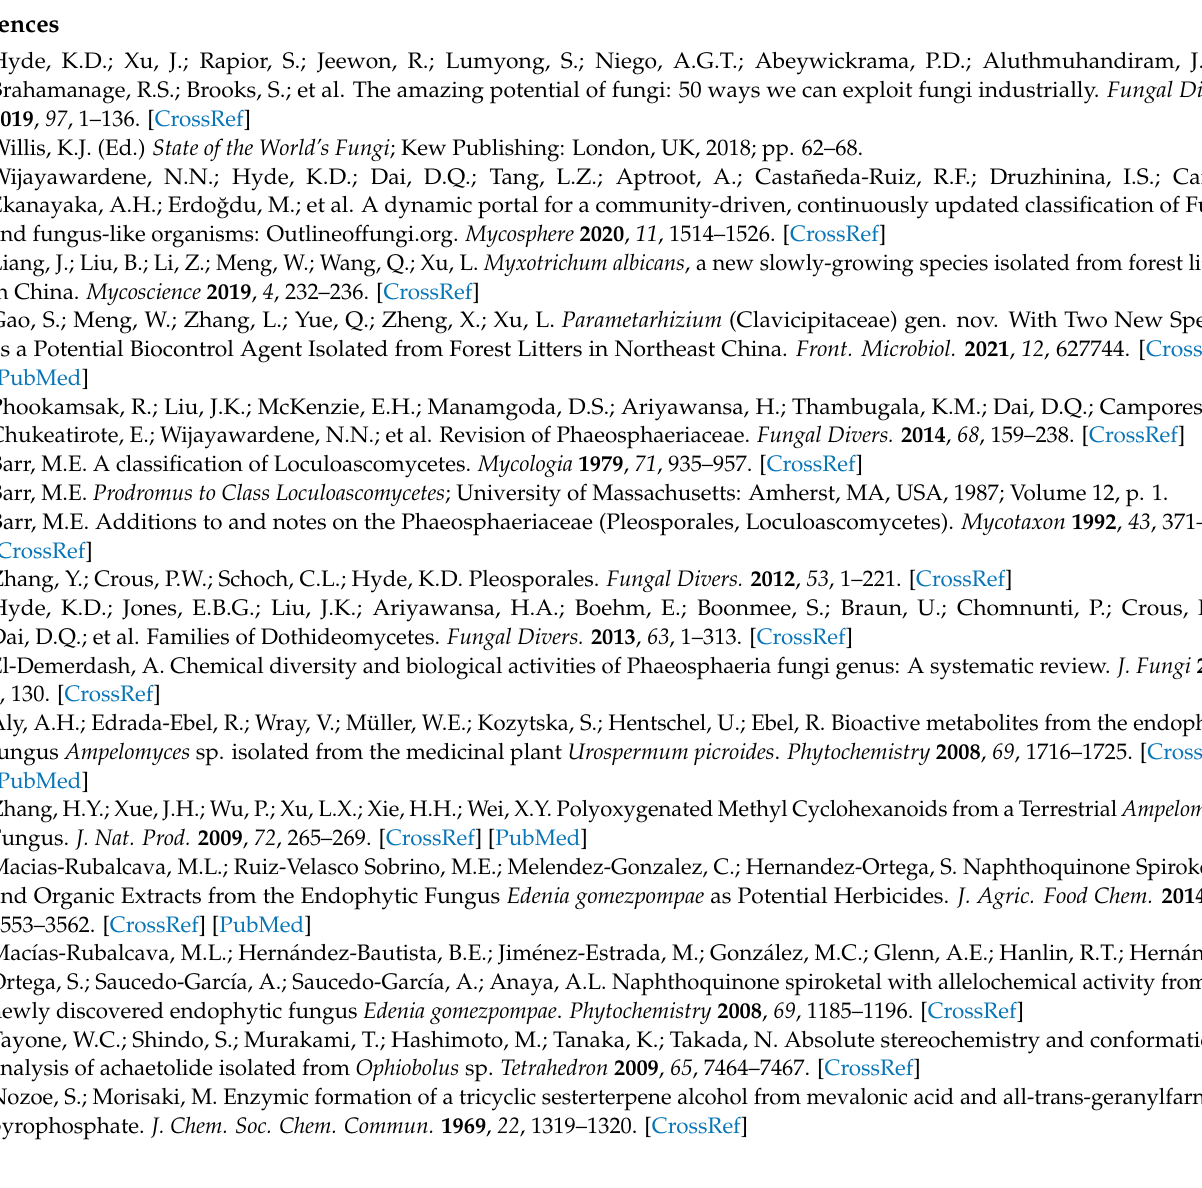
Chloroform-d) of compound 4 ; Figure S17: 13 C NMR spectrum (100 MHz, Chloroform-d) of com- pound 4 ; Figure S18: 1 H NMR spectrum (400 MHz, Methanol-D4) of compound 5 ; Figure S19: 13